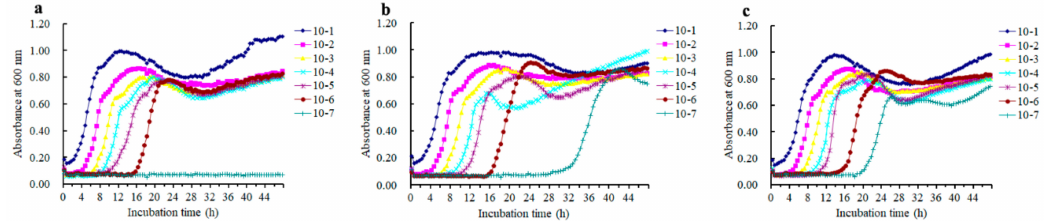
Figure 7. Regrowth of S. aureus mature biofilm after treatment with azalomycin F 5a . ( a – c ): S. aureus mature biofilms were treated with azalomycin F 5a at a concentration of 0.50, 1.0 and 2.0 µ g / mL, respectively. It is worth noting that Figures 7c and 5b are the